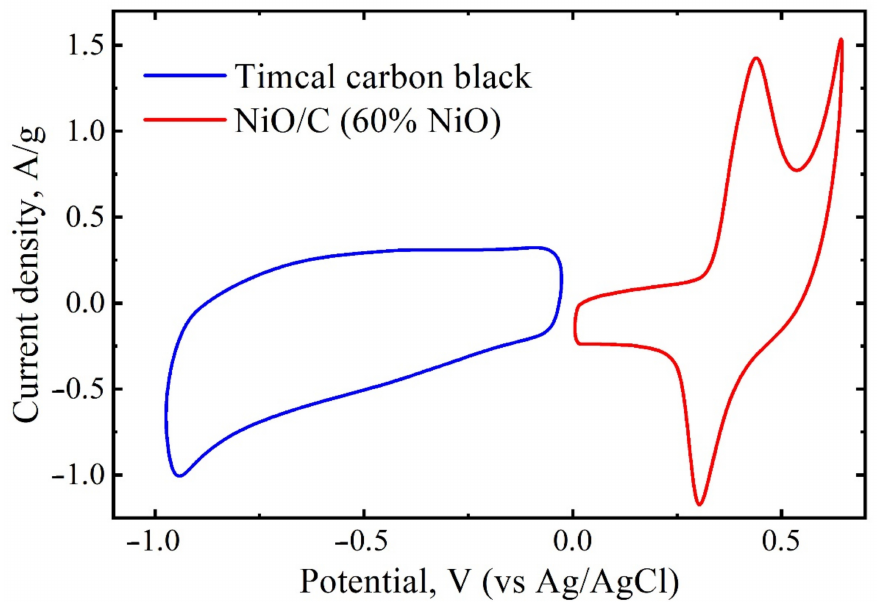
Figure 8. CV curves of carbon black Timcal Super C65 (CB) and NiO/C (60 wt% NiO) in a three- electrode cell in a 6 M KOH solution at a scan rate of 50 mV s − 1